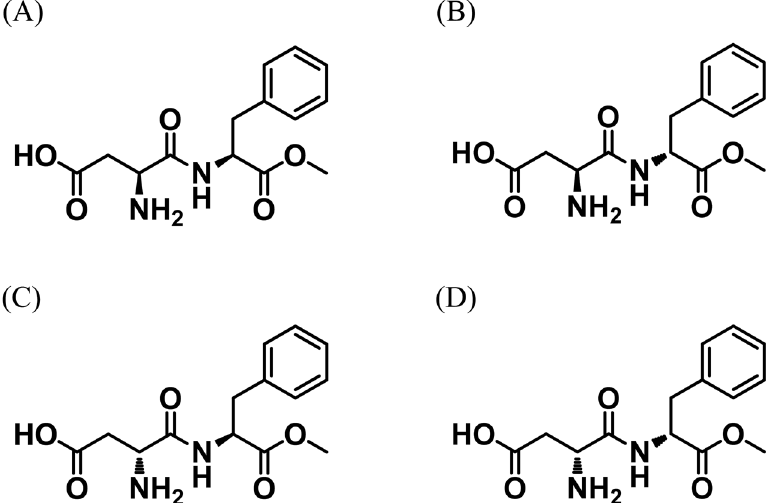
Fig 1. Chemical structures of aspartame (A), α -L-aspartyl-D-phenylalanine methyl ester (L, D-APM) (B), α -D-aspartyl-L-phenylalanine methyl ester (D, L-APM) (C), and α -D-aspartyl-D-phenylalanine methyl ester (D, D-APM)